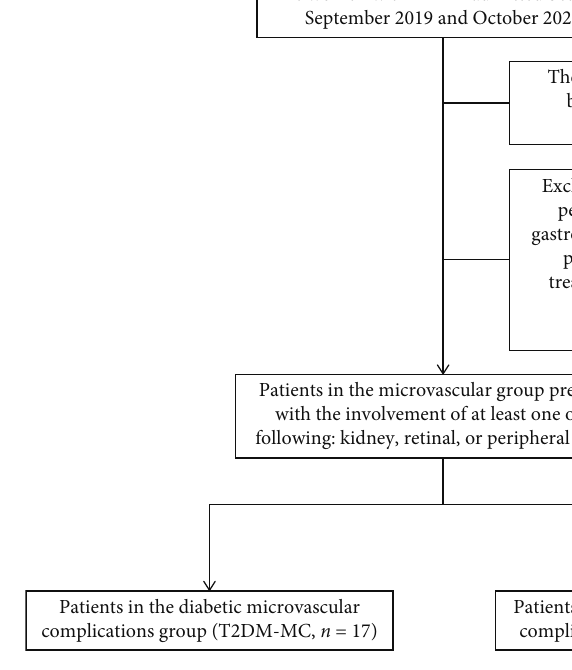
Figure 1: Flow graph illustrating study process. Table 1: Primer sequences of the intestinal bacterial